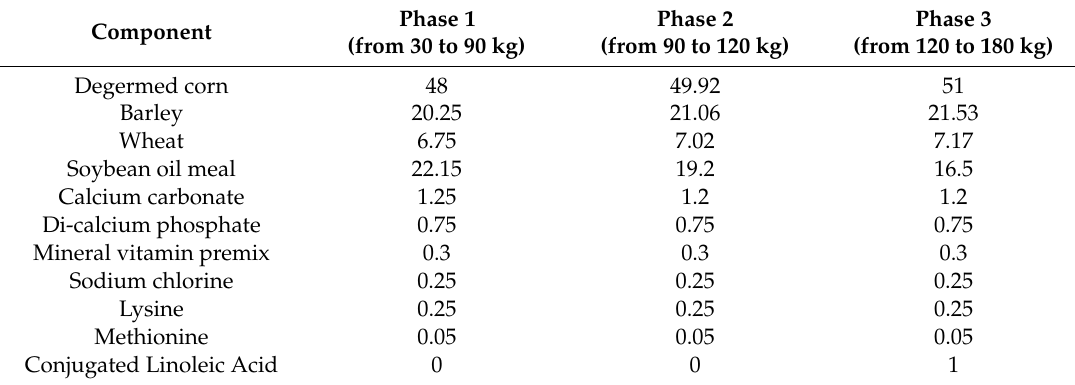
Table 1. Percentage composition of feed in the three-phase feeding